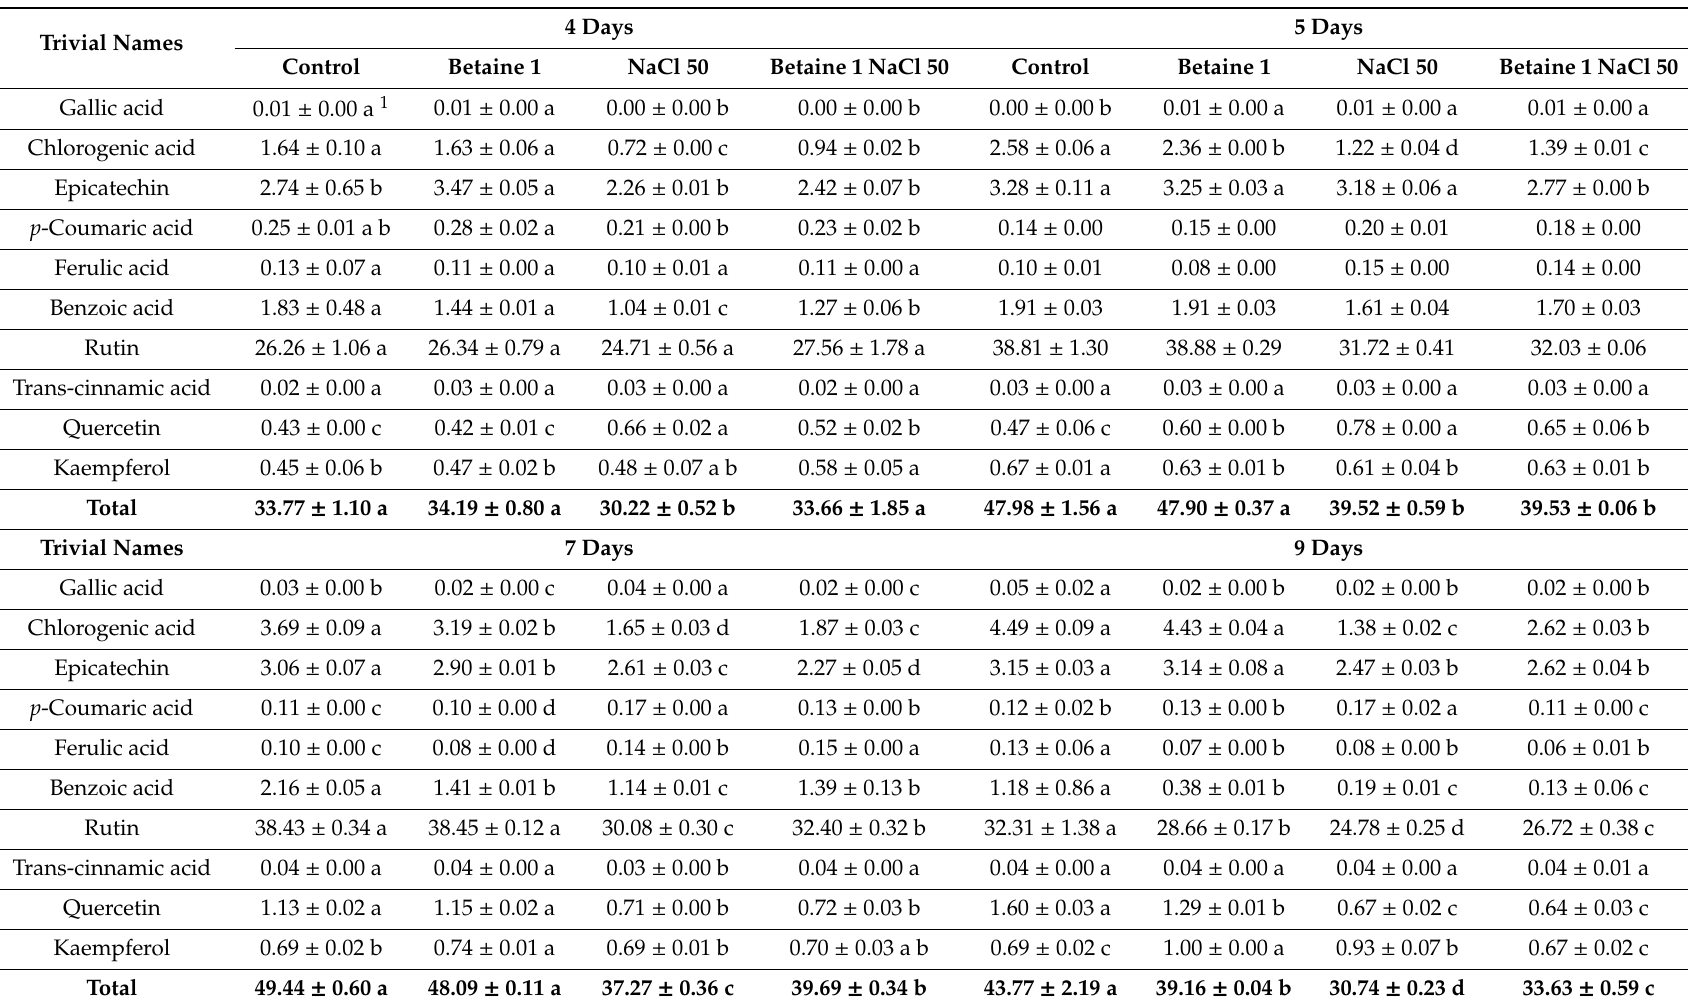
Table 4. Phenylpropanoid compound contents (mg / g dry wt.) in Tartary buckwheat